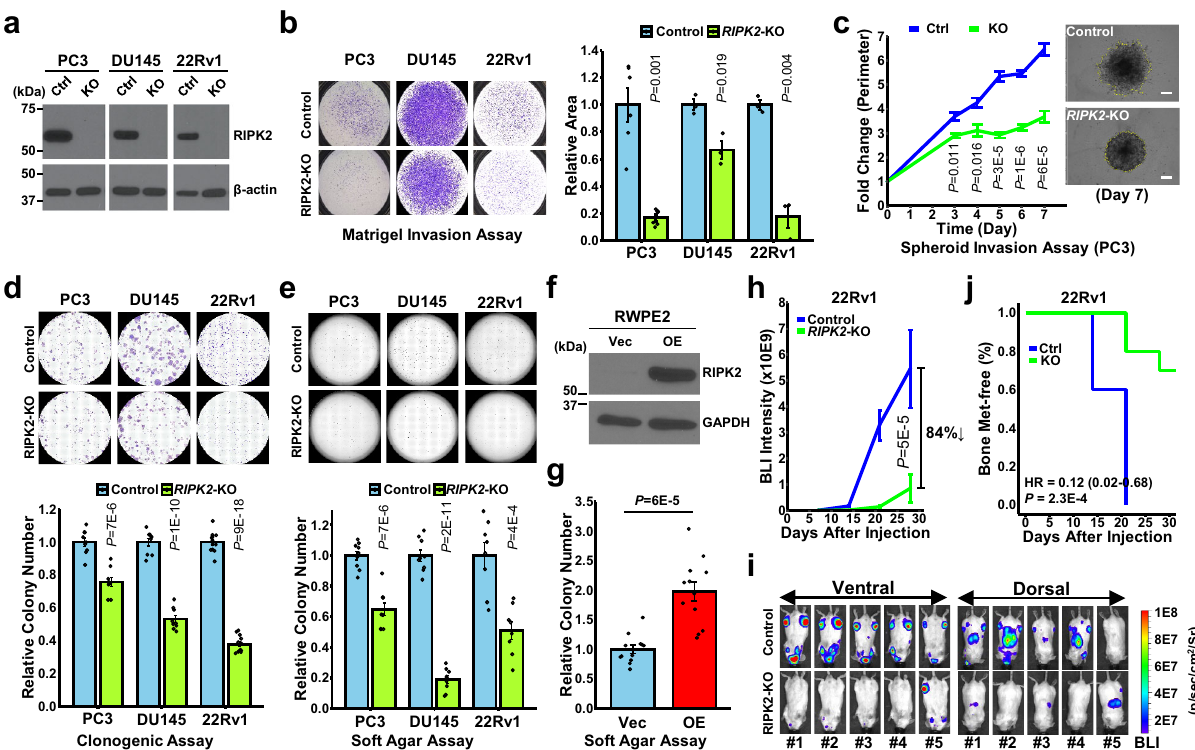
Fig. 2 RIPK2 is required for PC metastasis. a Representative immunoblots of RIPK2 in total lysates derived from control PC cells and cells with RIPK2 knockout by CRISPR/Cas9 using gRNA10. Experiments were repeated twice independently with similar results. Ctrl: control; KO: knockout. b Representative images (left) and quanti fi cation (right) of Matrigel invasion assay of control or RIPK2 -KO PC cells. N = 6, 3, 3 biologically independent samples per group for PC3, DU145, and 22Rv1 cells, respectively. c Quanti fi cation and representative images of 3D spheroid invasion assay of control or RIPK2 -KO PC3 cells ( n = 6 biologically independent samples per group). Scale bars, 300 μ m. d , e Representative images (upper) and quanti fi cation (lower) of d anchorage-dependent or e anchorage-independent colony formation assay of control or RIPK2 -KO PC cells. N = 9, 9, 12 biologically independent samples per group for PC3, DU145, and 22Rv1 cells, respectively ( d ). N = 9, 9, 8 biologically independent samples per group for PC3, DU145, and 22Rv1 cells, respectively ( e ). f Representative immunoblots of the indicated proteins in total lysates derived from control and RIPK2 -overexpressing (OE) RWPE-2 cells. Experiments were repeated twice independently with similar results. Vec: vector control; OE: overexpression. g Quanti fi cation of anchorage- independent colony formation assay of control and RIPK2 -OE RWPE-2 cells ( n = 12 biologically independent samples per group). h – j Luciferase-tagged control or RIPK2 -KO 22Rv1 cells were intracardially injected into male SCID/Beige mice, which were monitored every week for 4 weeks by in vivo bioluminescence imaging (BLI). h Total BLI intensities over time ( n = 5 biologically independent mice per group). i BLI images taken 4 weeks after the i.c. injection from the ventral and dorsal sides. j Percentages of knee joints free of metastasis ( n = 10 biologically independent joints per group) over time. Nominal p- values were determined by unpaired two-tailed Student ’ s t -test ( b – e , g ), two-way ANOVA ( h ), or two-sided log-rank test ( j ). Data are shown as mean ± SEM ( b – e , g , h